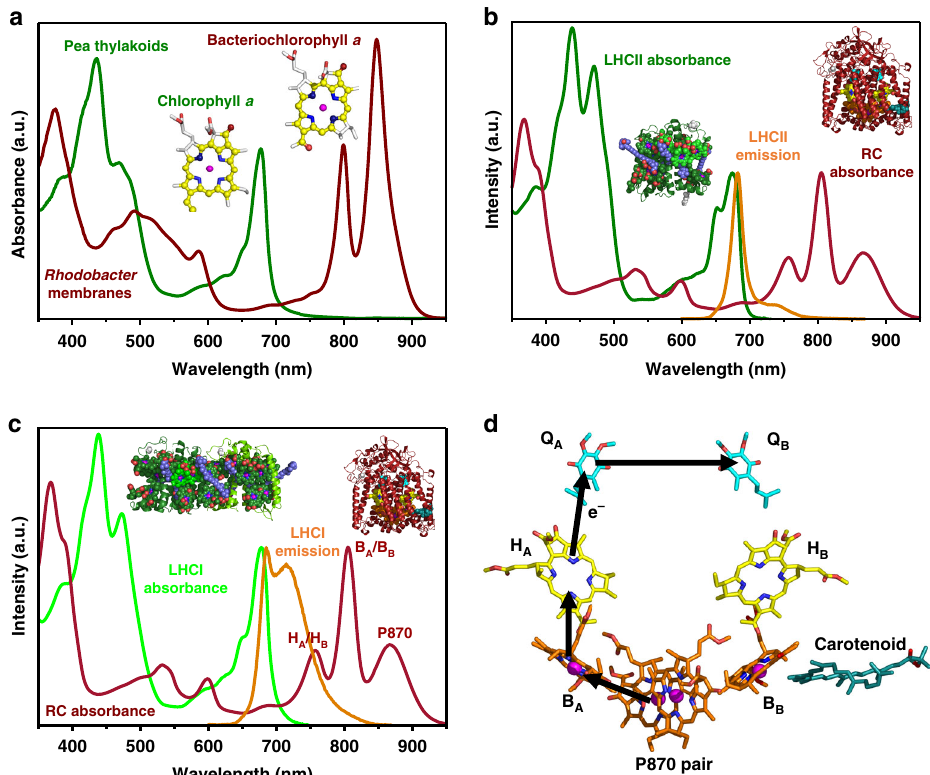
Fig. 1 Component absorbance, emission and mechanism. a Thylakoid membranes from oxygenic phototrophs such as pea and chromatophore membranes from anoxygenic phototrophs such as Rba. sphaeroides have complementary absorbance spectra due to differences in the electronic structures of the macrocycle π electron systems of chlorophyll and bacteriochlorophyll (see also Supplementary Fig. 1). b The major plant light-harvesting complex LHCII harvests solar energy in regions where absorbance by Rba. sphaeroides RCs is weak, notably around 650 nm, and its emission spectrum overlaps the absorbance spectrum of the RC between 640 and 800 nm. c The red-enhanced emission spectrum of heterodimeric plant LHCI has a stronger overlap with the absorbance spectrum of the Rba. sphaeroides RC, particularly the coincident absorbance bands of the bacteriopheophytins (H A /H B ). d Architecture of the RC cofactors and the route of four-step charge separation which oxidises P870 and reduces Q B . The bacteriochlorophylls (orange carbons) and bacteriopheophytins (yellow carbons) give rise to the absorbance bands labelled in c . Further descriptions of pigment-protein structures and their sources are given in Supplementary Fig.